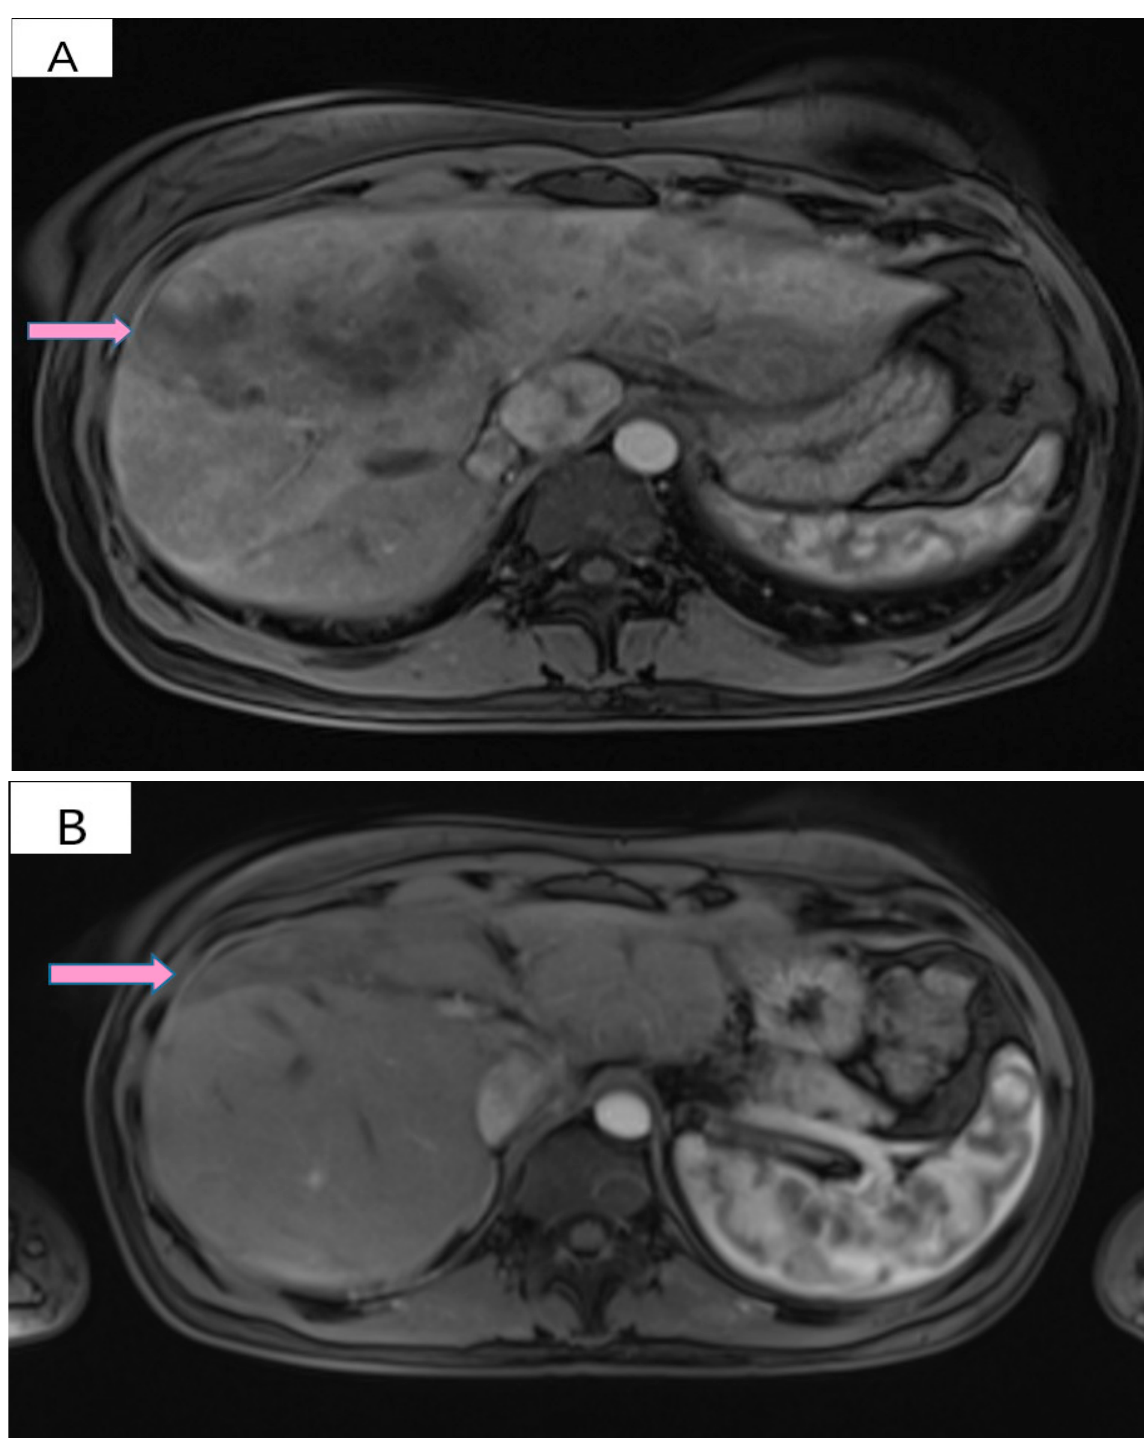
Figure 3. ( A ) Pretreatment MRI scan of the abdomen showing a large hypodense mass in the left lobe of the liver—segments VIII and IV (marked by arrows). ( B ) MRI scan showing a dramatic decrease in size of the metastasis (marked by arrows) in the left lobe of the liver after treatment with six cycles of Pertuzumab, Trastuzumab and Paclitaxel.